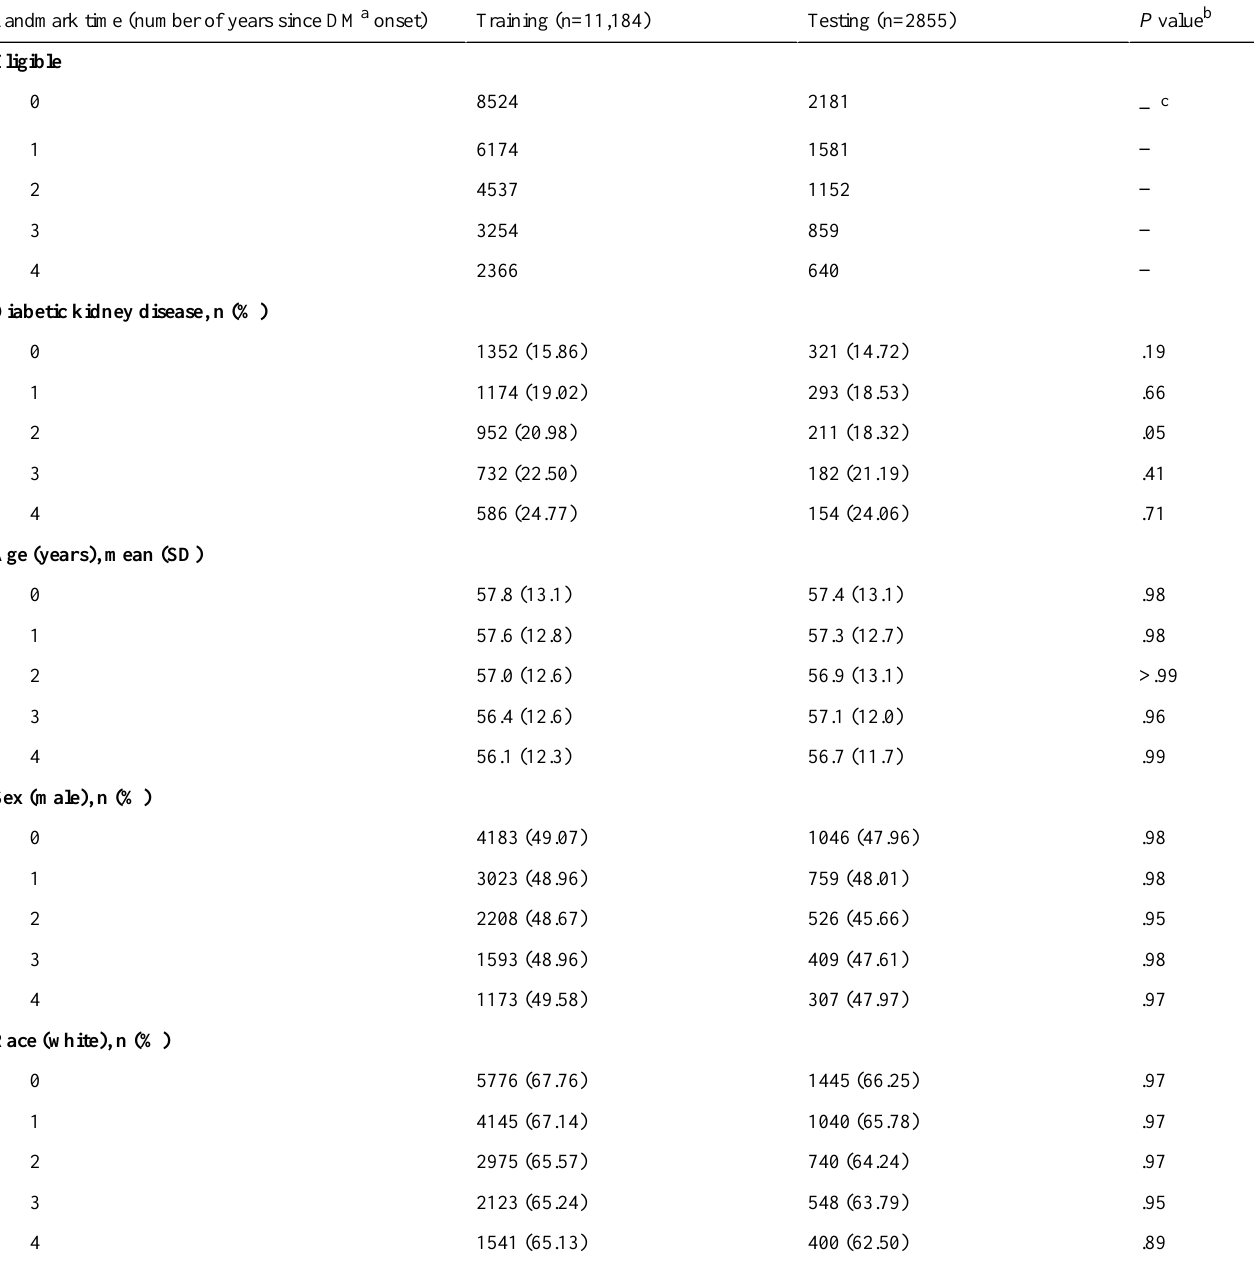
Table 4. Case-mix shift in training and testing